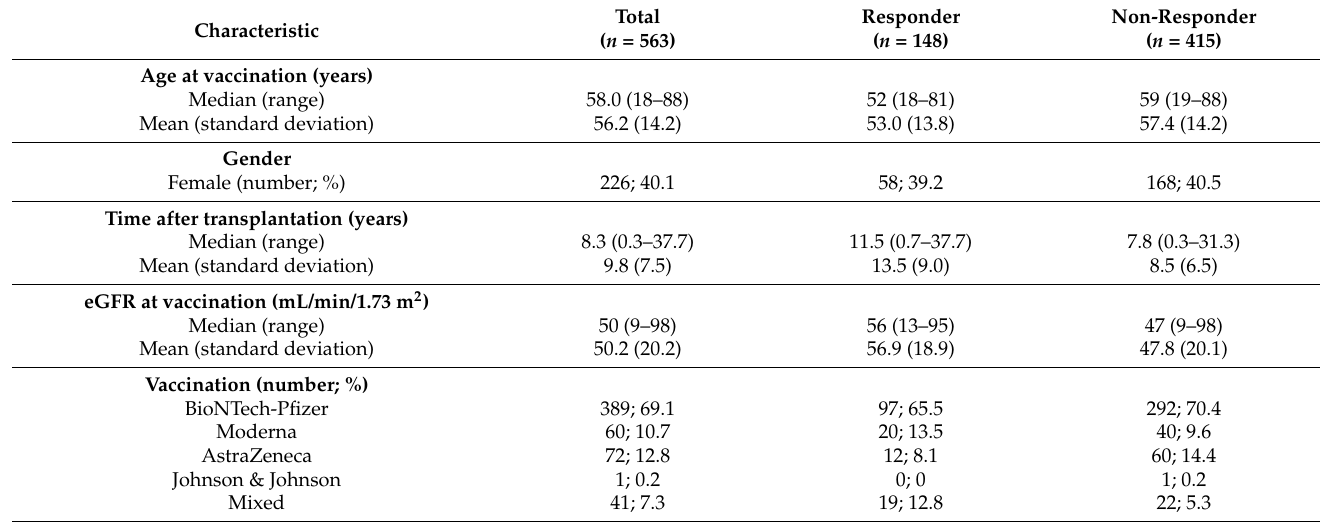
Table 1. Patient characteristics of responders and non-responders after vaccination against